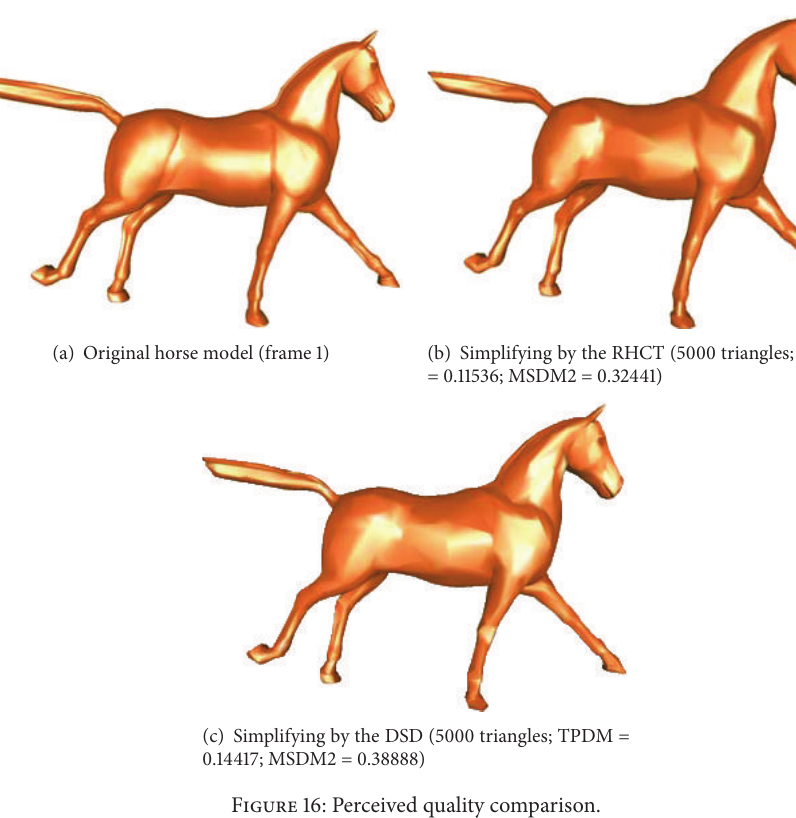
Figure 16: Perceived quality comparison.